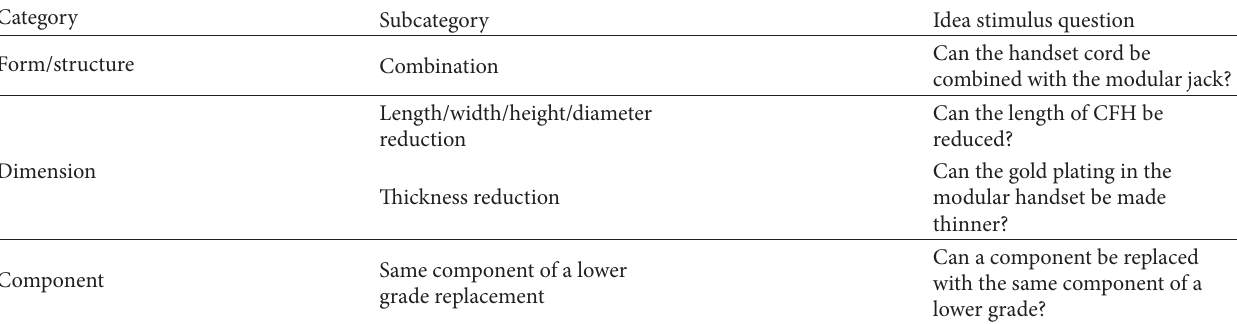
Table 13: Four subcategories for PBA SUB-etc. and CFH.